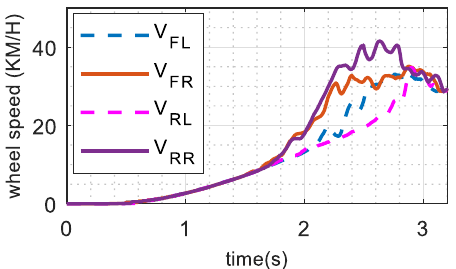
Figure 10. Controller output of wheel speed.